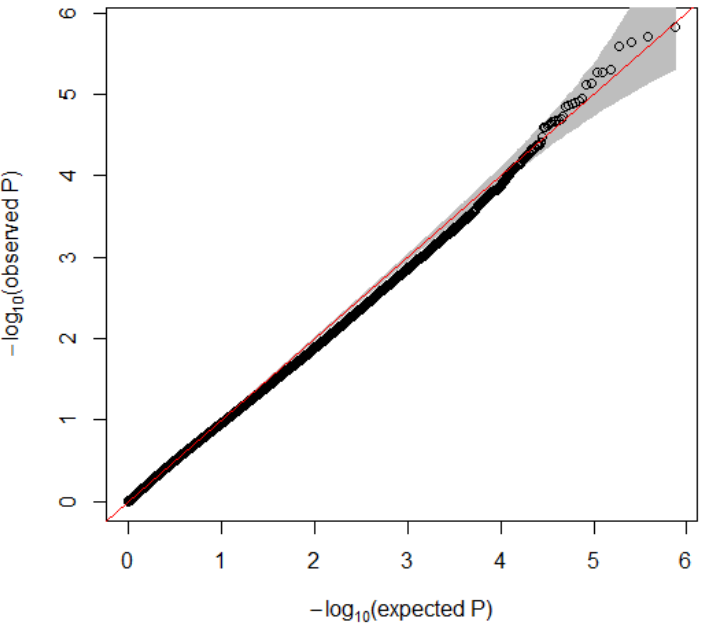
Figure 1. Quantile-quantile plot of expected ( x -axis) versus observed ( y -axis) p -values. At lower p -values there is a slight deviation from the expected pattern which may indicate presence of non- random association. The circles represent the CpG sites investigated in this study. The red line indicates the expected pattern if there is no difference between expected and observed p -values, and the grey area indicates a confidence interval of 95%. log 10 , logarithm base 10. Table 1. Differentially methylated positions (DMPs) with a p -value < 1 × 10 − 5 .